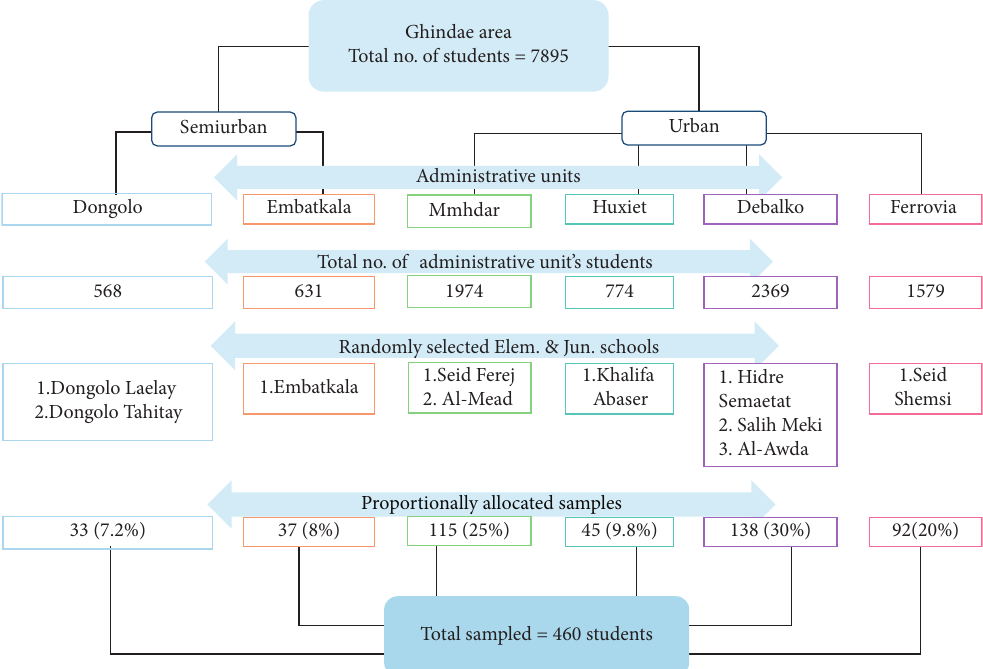
Figure 1: Schematic presentation of sampling procedure in administrative units of Ghindae town,